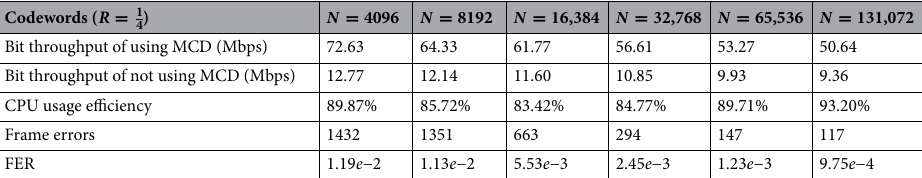
Table 4. Six kinds of Polar codes are evaluated with 120,000 blocks. The number of threads MPI opens is 8. The CPU usage efficiency is the peak value that appears when codewords are evaluated. Take the bit throughput of average value by multiple measurements.